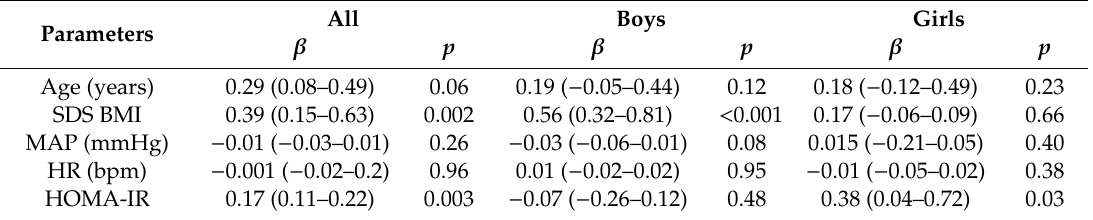
Table 3. Determinants of carotid-femoral pulse wave velocity. Multiple linear regression model. Parameters